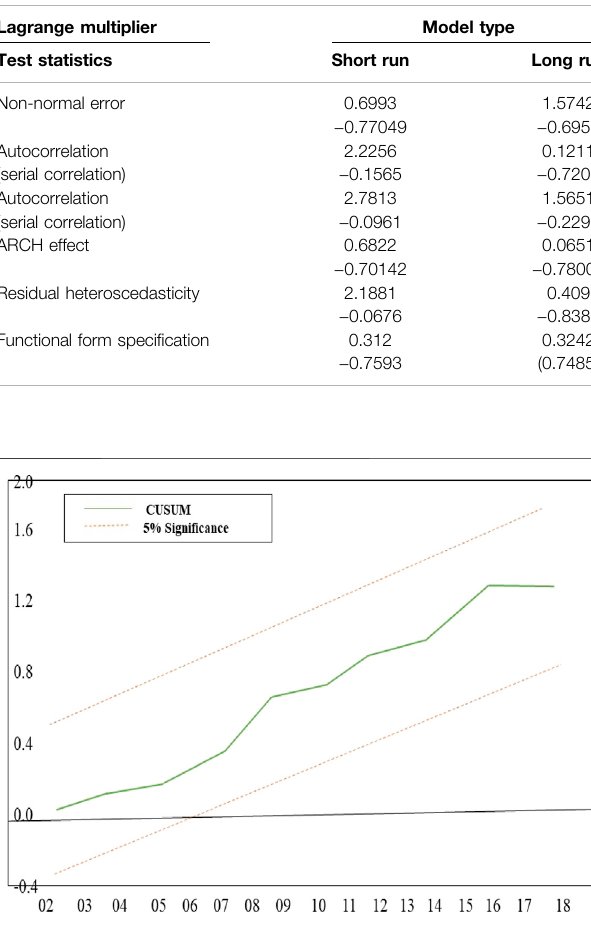
TABLE 6 | Parsimonious estimation for long-run model. TABLE 7 | Diagnostic tests result of short and long run.